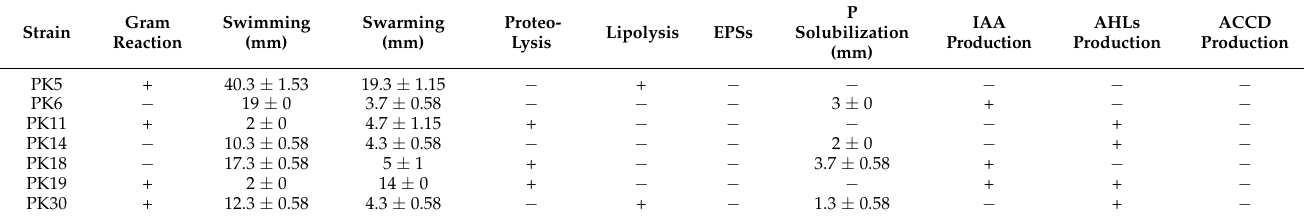
Table 1. Results obtained by biochemical and physiological tests on bacterial strains isolated from olive rhizosphere. Swimming, swarming and P solubilization results are displayed as colony